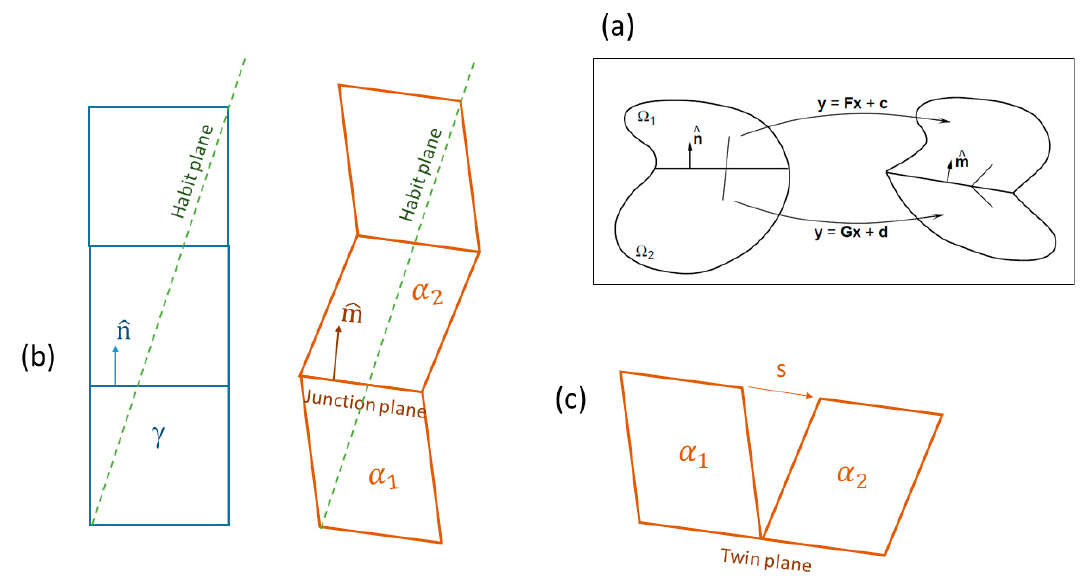
Figure 18. Phenomenological Theory of Martensitic Crystallography (PTMC)’s principles with a simple 2D example square ( γ )–parallelogram ( α ) transformation. ( a ) Local compatibility criterion at the junction plane, from [30]. ( b ) Compatibility criterion combined with the hypothesis that the habit plane results from a linear combination of two distortion variants and should be an invariant strain